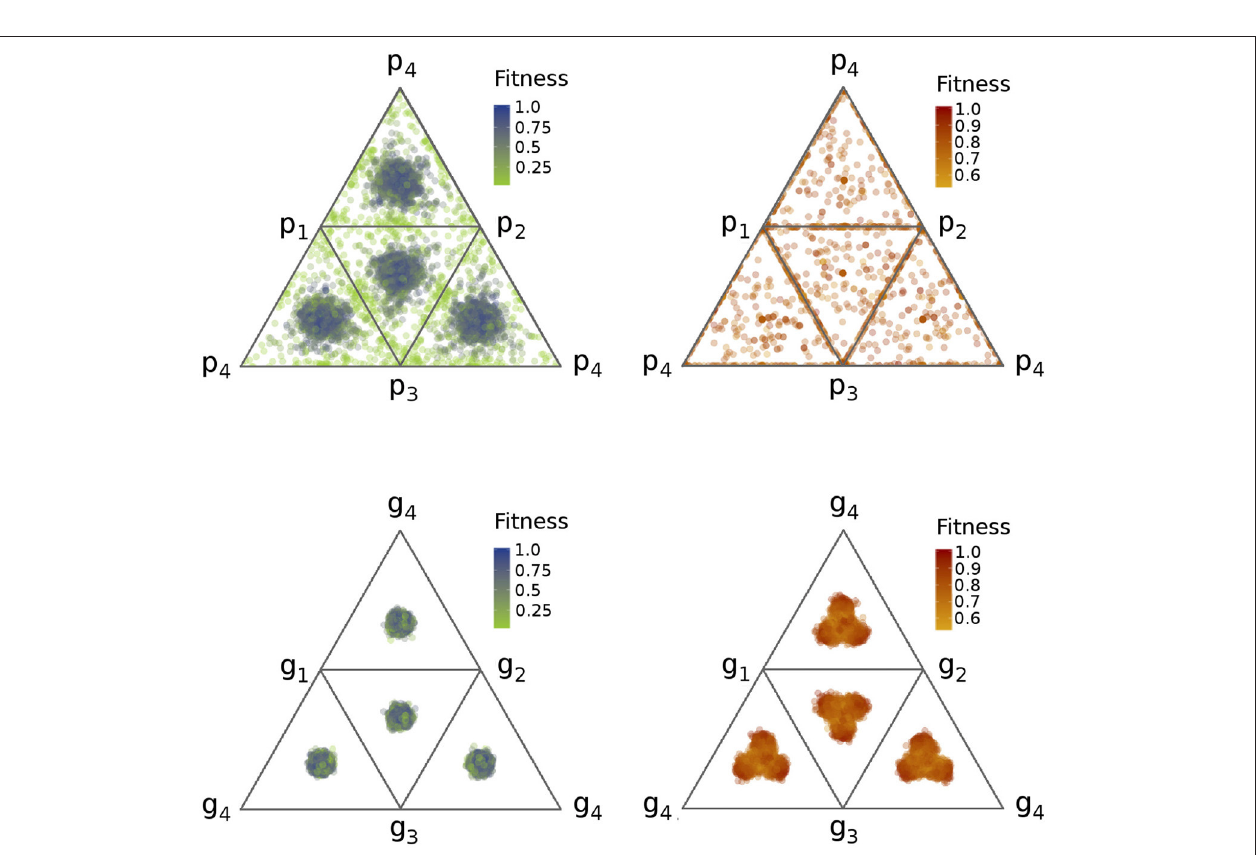
FIGURE 5 | Phenotypic (top) and genetic (bottom) profiles in the T = 4 case with weaker trade-off ( α = 1.25). The figure captures tetrahedron nets, where each triangle is a simplex calculated from the three noted tasks, similarly to the simplexes on Figure 4 . Thus, the faces of the tetrahedrons show projections of the 3D mass of points. Each point corresponds to an individual, and plots contain all group members. Reddish colors represent the producer, greenish the subsistence case. For further parameters, see Table 1 .